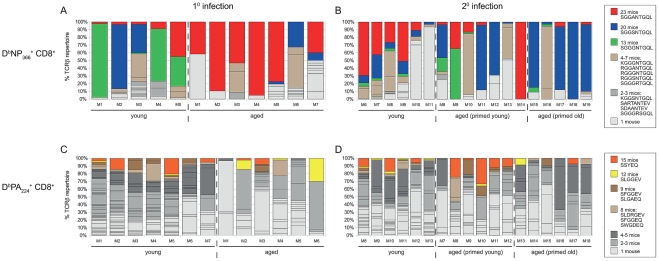
Comparison between aged and young mice of the dominance of shared DbNP366
+CD8+ Vβ8.3+ and DbPA224
+CD8+ Vβ7+ TCR clonotypes during primary and secondary (primed-young and primed-old) infections.Shown are the percentages of the DbNP366
+CD8+Vβ8.3+ (A, B) and DbPA224
+CD8+Vβ7+ (C, D) TCR repertoires per mouse that are comprised of aa clonotypes shared between a particular number of mice (indicated by colour-coding) during primary (A, C) and secondary (B, D) infections. The number of mice sharing a TCR clonotype was determined across young and aged mice and both primary and secondary challenges. For example, the public DbNP366
+CD8+Vβ8.3+ TCR clonotype SGGANTGQL (red) was observed in 23 out of 30 mice (A, B). This clonotype contributed to 95% of the primary DbNP366
+CD8+Vβ8.3+ TCR repertoire of aged mouse M4 (A). There were five DbNP366
+CD8+Vβ8.3+ TCR clonotypes that were each observed in a number of mice ranging between 4 and 7 mice (beige). Three of these five clonotypes contributed to the DbNP366
+CD8+Vβ8.3+ TCR repertoire responding to secondary infection in young mouse M7 (B, as indicated the three beige segments). Multiple unshared clonotypes (light grey), which were observed in only one mouse, contributed to the TCR repertoires of many of the mice (as indicated by multiple light grey segments per column).